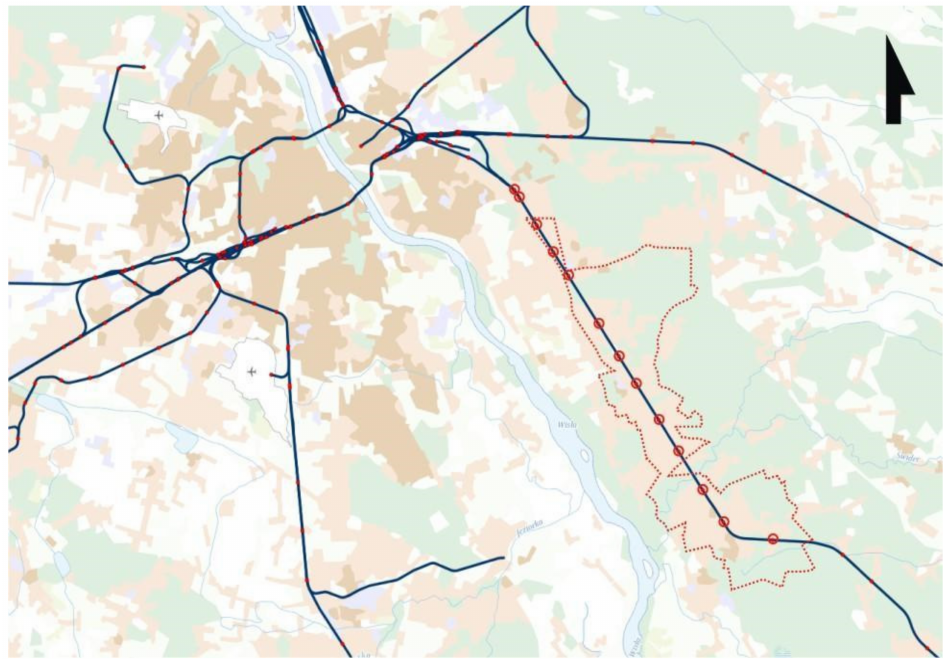
Figure 3. Contemporary spatial layout of Warsaw with the railway network. Red dots mark historical railway stations, and a red dotted line demarcates the area of former summer resorts on the Otwock Line, by M. G ó